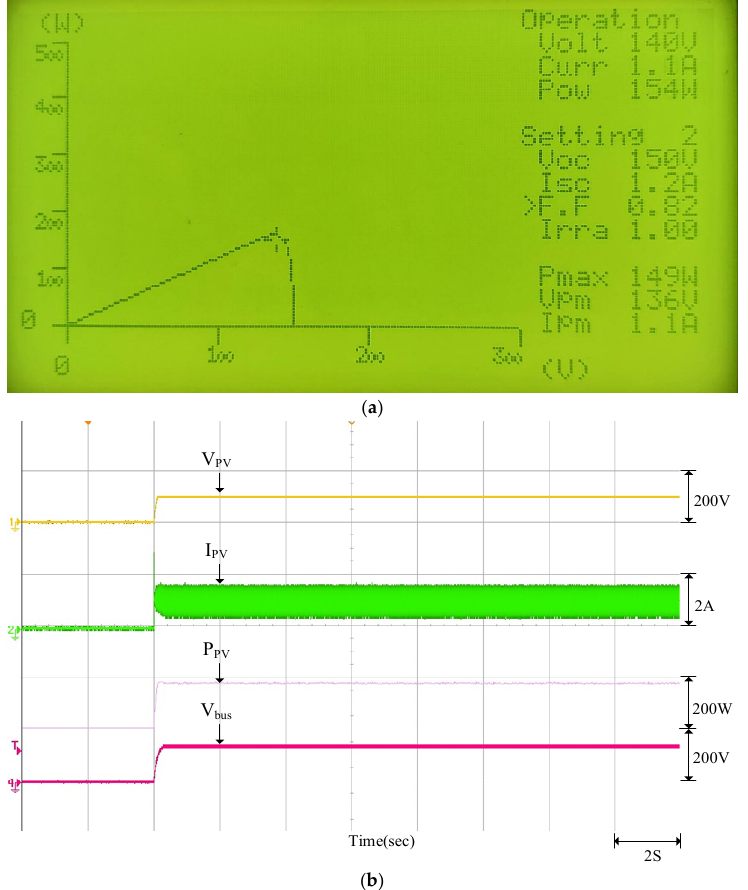
Figure 11. Under the maximum power tracking when the photovoltaic module outputs 150 W: ( a ) P–V characteristic curve diagram; ( b ) actual tested waveform.